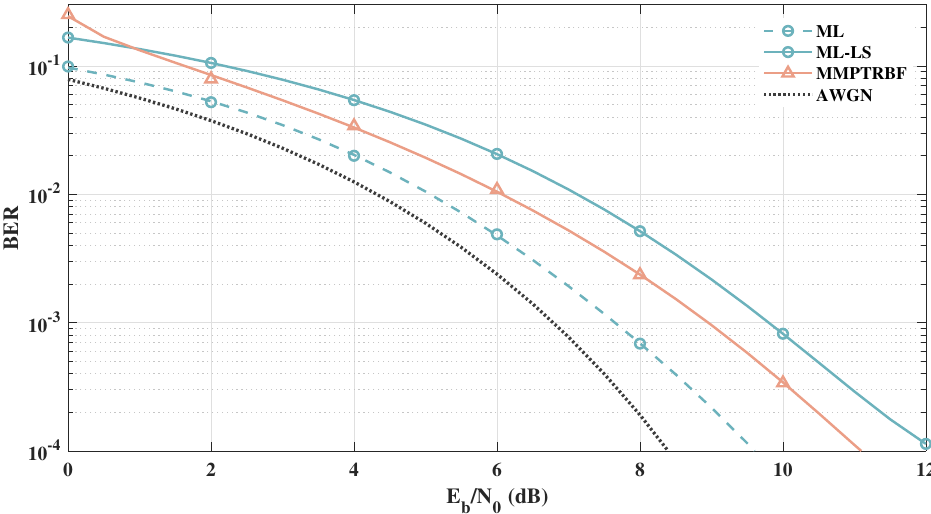
Figure 17. Systems with M T = 8 and M R = 1 antennas for 4-QAM